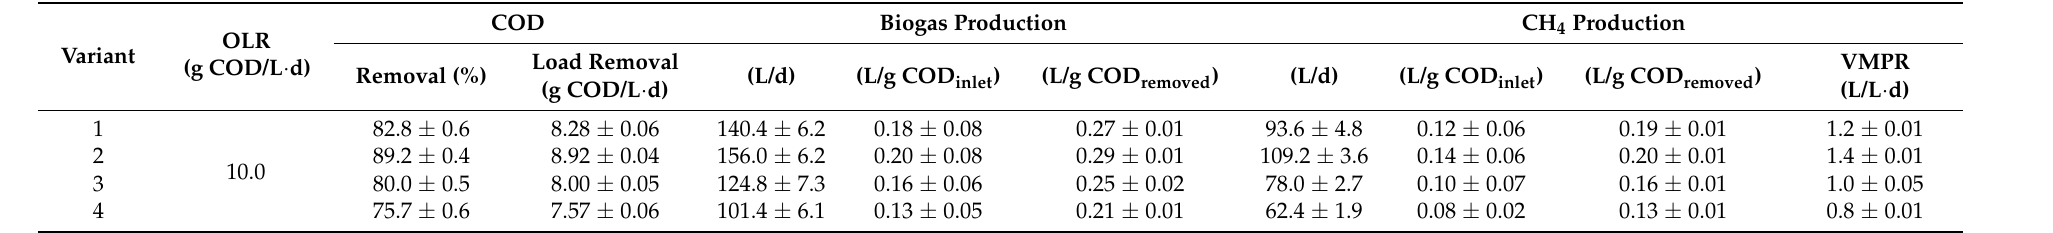
Table 5. Removal of organic compounds and production of biogas and CH 4 in stage